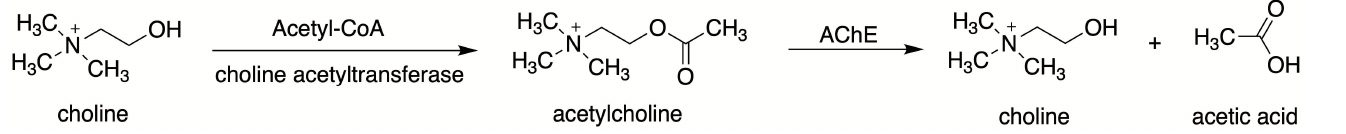
Figure 1. Synthesis and degradation of acetylcholine. Abbreviations: Acetyl-CoA, acetyl-coenzyme A; AChE, acetylcholine esterase.